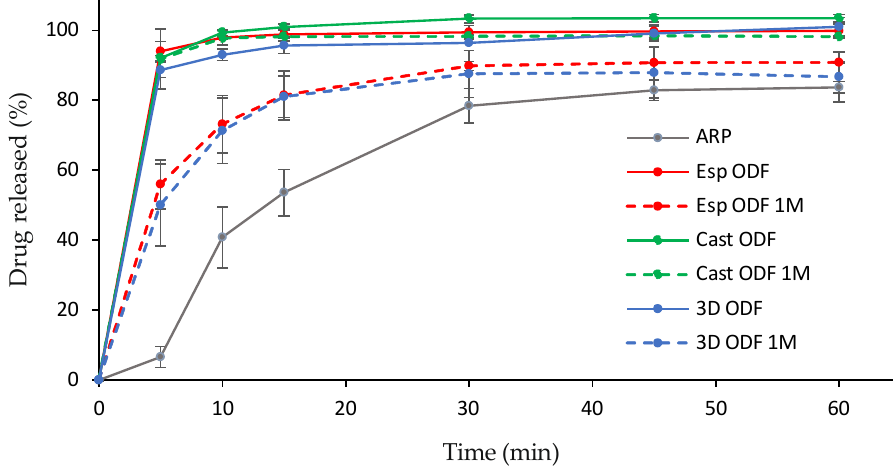
Figure 9. Dissolution profiles of raw ARP (grey line) and ODFs prepared with electrospinning (red line), casting (green line) and 3D printing (blue line) method after preparation (solid line) and after one month storage at 25 °C and 60% RH (dashed lines).